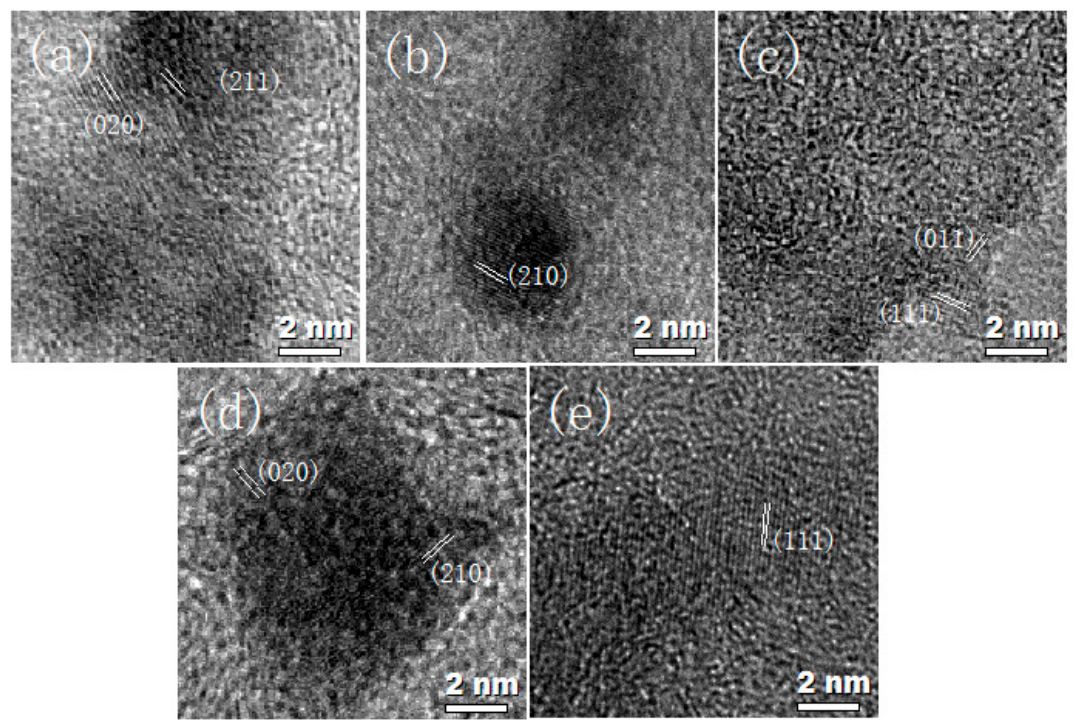
Figure 6. High resolution TEM images of the FeSe 2 /C prepared with different Se/Fe ratios.